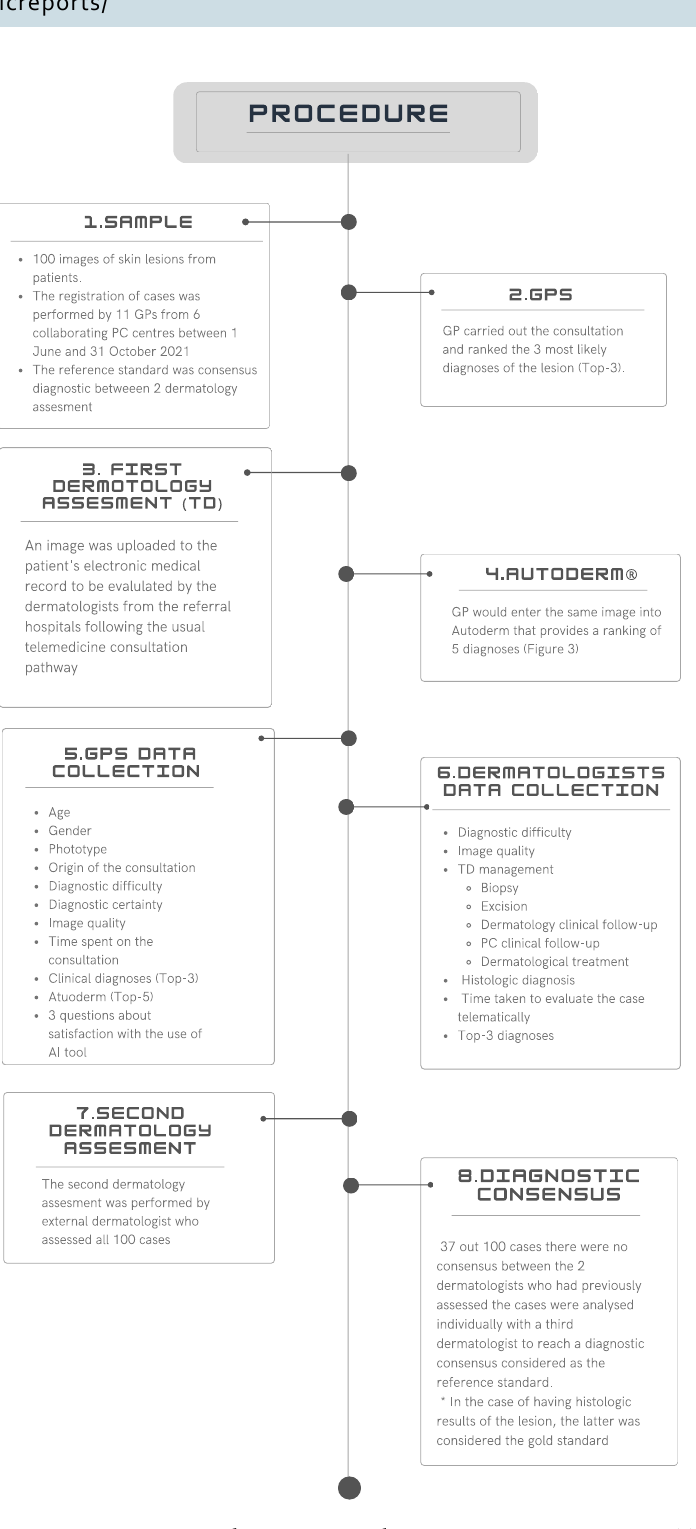
Figure 2. Diagram procedure. GPs: general practitioners; PC: primary care; TD: teledermatology; AI: artificial